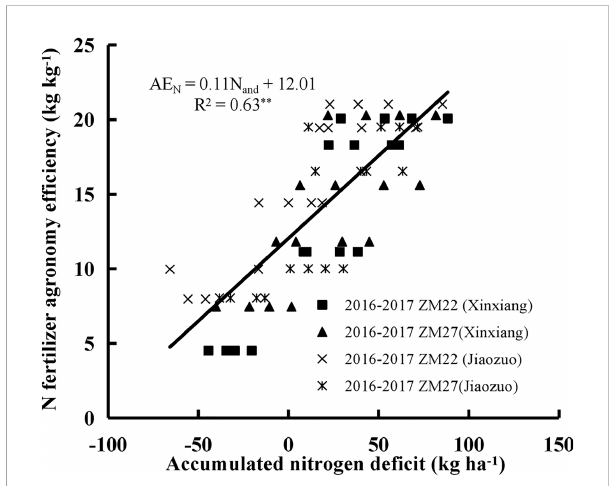
FIGURE 4 The relationship between accumulated N de fi cit and N